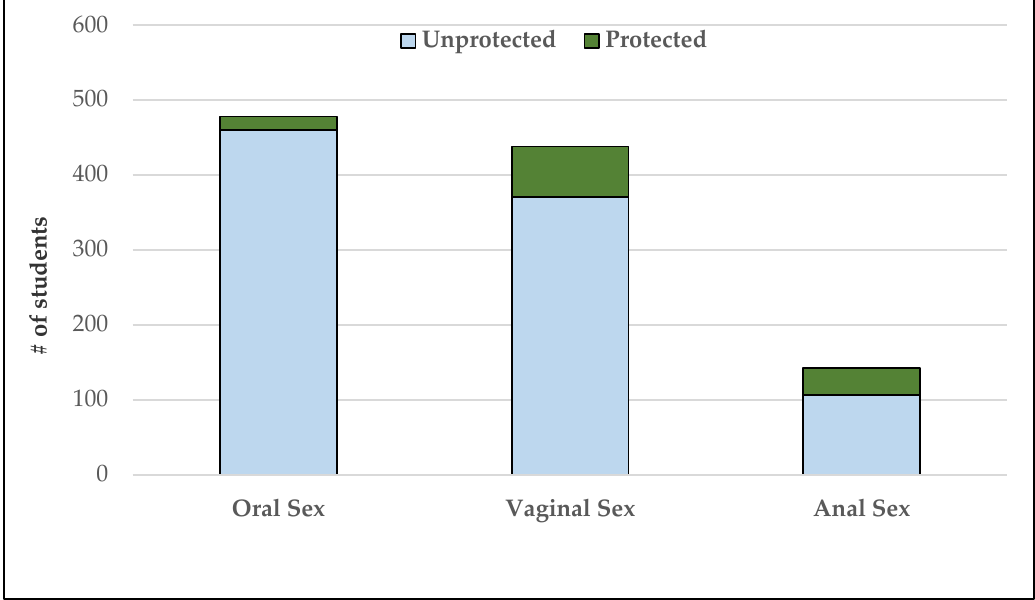
Figure 1. Students’ Sexual Activity: Ever Unprotected vs. Always Protected ( n =